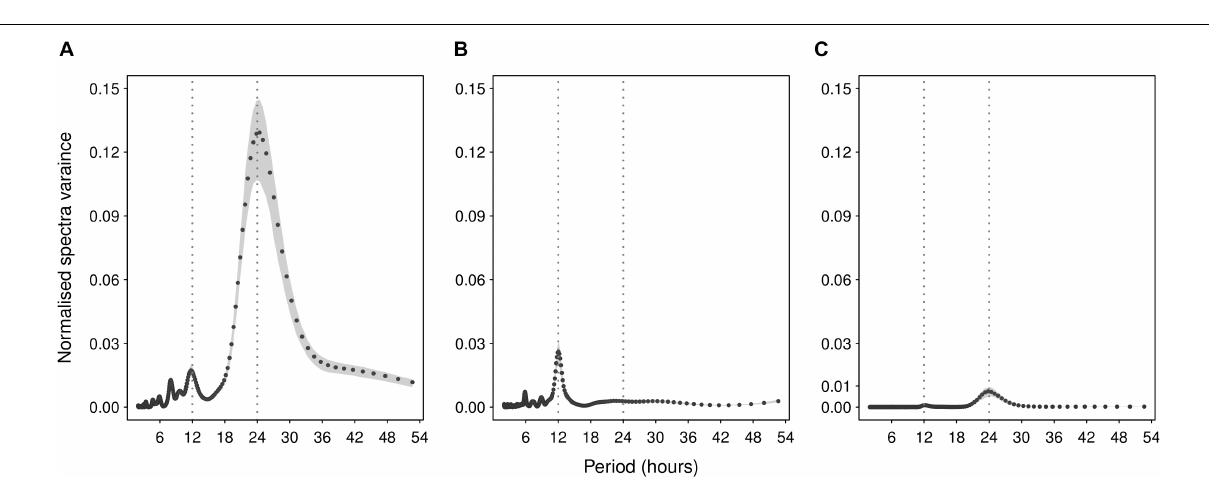
FIGURE 2 | Illustrative examples of spectral analyses of Chesttemp or Coretemp time series. Plots of spectral density estimates (line) with respective 90% confidence intervals (gray area) for Chesttemp in panel (A) a 71 y.o female (subject A in ST2), and panel (B) a 34 y.o. male (subject B in ST2); and for Coretemp in panel (C) a 50 y.o. female (subject C in ST2). Corresponding dominant periods and SGC estimates (in hours) with 90% confidence interval were: (A) 24.4 h (23.3, 25.0) and 20.6 h (20.2, 20.9); (B) 12.0 h (11.9, 12.2) and 10.9 h (10.8, 11.2); (C) 23.8 h (23.3, 24.4) and 20.6 h (19. 9, 21.2). Note, for Chesttemp, higher spectral variance if largest peak near 24 h for panel (A) and smaller variance if largest peak near 12 h for panel (B)